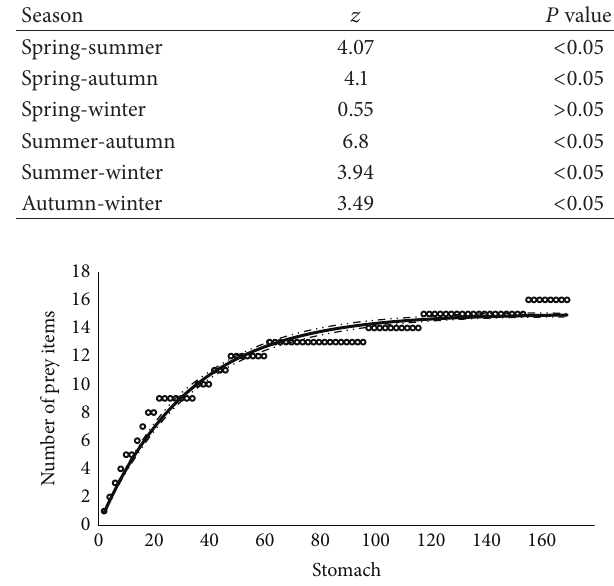
Figure 2: Prey item accumulation curve showing the fitted negative exponential model to diet data of Panama grunt. The form of the fitted model is 𝑆 𝑡 = 15(1 − 𝑒 −0.062𝑡 𝑖 )